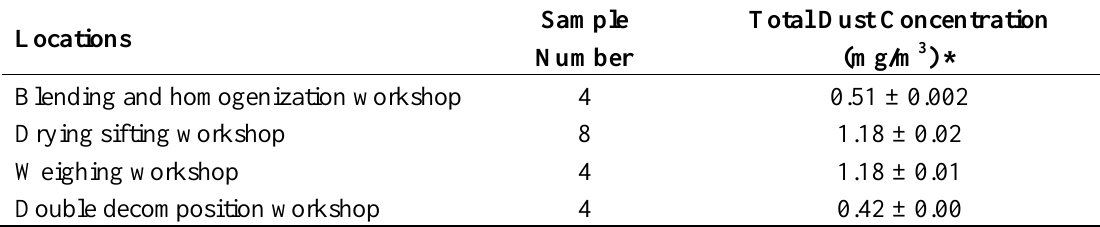
Table2. Total dust concentrations of major workshop in the factory for producing ammonium perchlorate (Mean ±